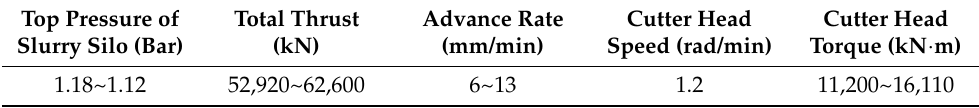
Table 5. The shield tunnelling parameters.